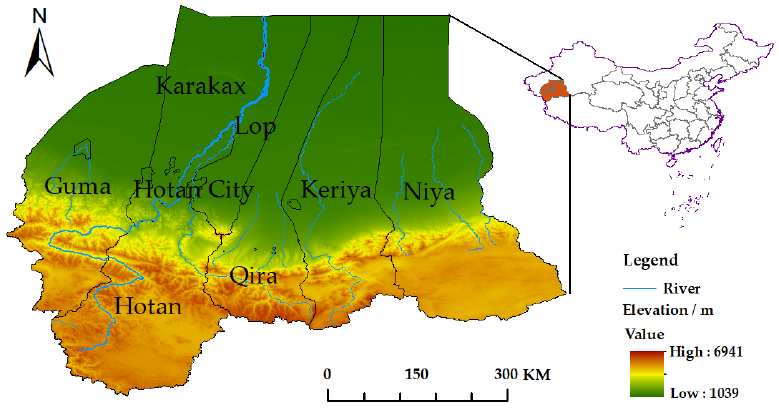
Figure 1. Location of Hotan area and its prefectures.